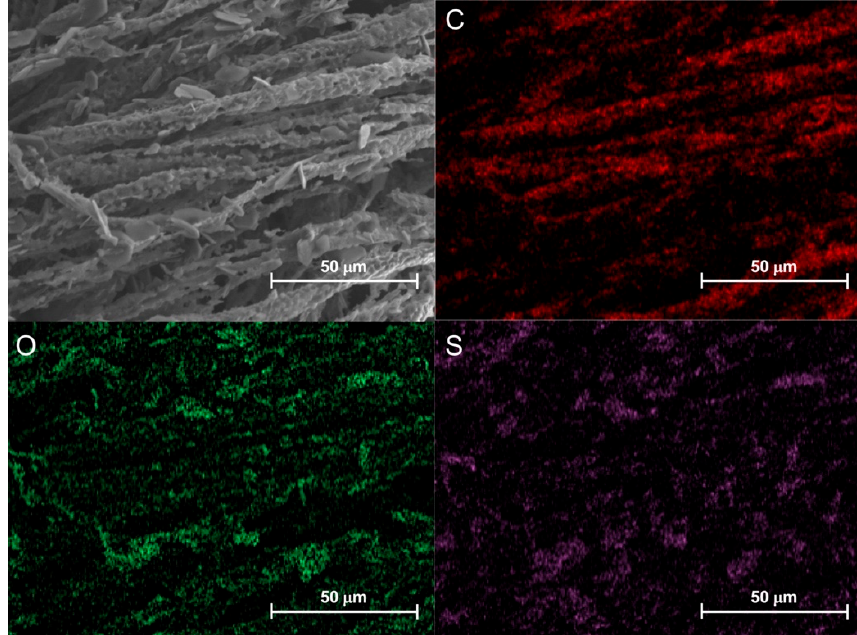
Figure 15. EDX analysis of COT/M–G 50 –C 50 residue after cone calorimetry tests. Distribution of carbon (C), oxygen (O), and sulfur (S).